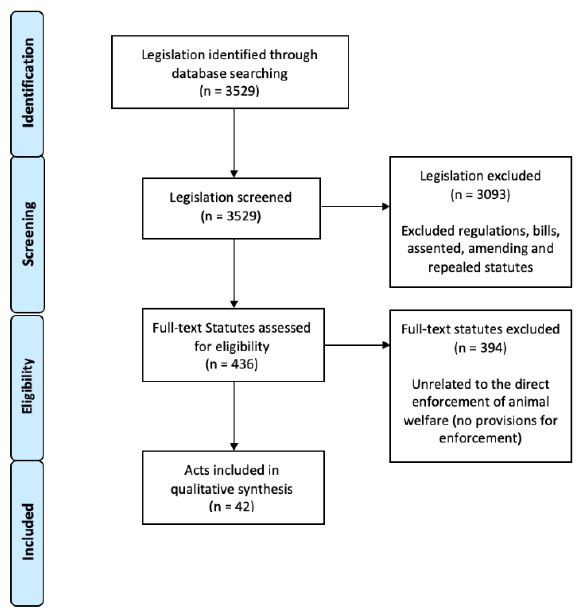
Figure 1. PRISMA [9] flow diagram showing the data selection process of animal protection stat- utes.